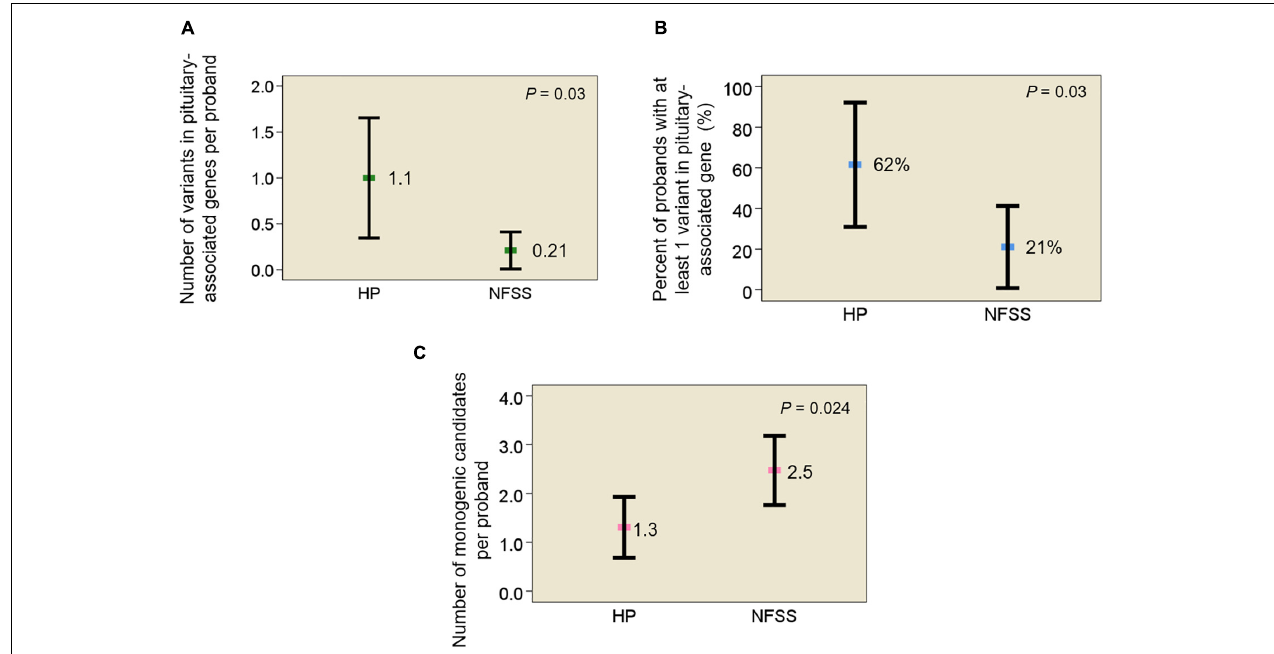
FIGURE 1 | Rare, predicted-pathogenic variants in subjects with congenital hypopituitarism and non-familial short stature. (A) Mean number of rare, predicted-pathogenic variants per proband in 42 genes associated with pituitary development. (B) Percent of probands with at least 1 variant in any of 42 pituitary-associated genes. (C) Mean number of monogenic candidates for the condition (hypopituitarism or non-familial short stature) per proband. Square indicates mean. Error bar shows 95% confidence interval. HP, congenital hypopituitarism; NFSS, non-familial short